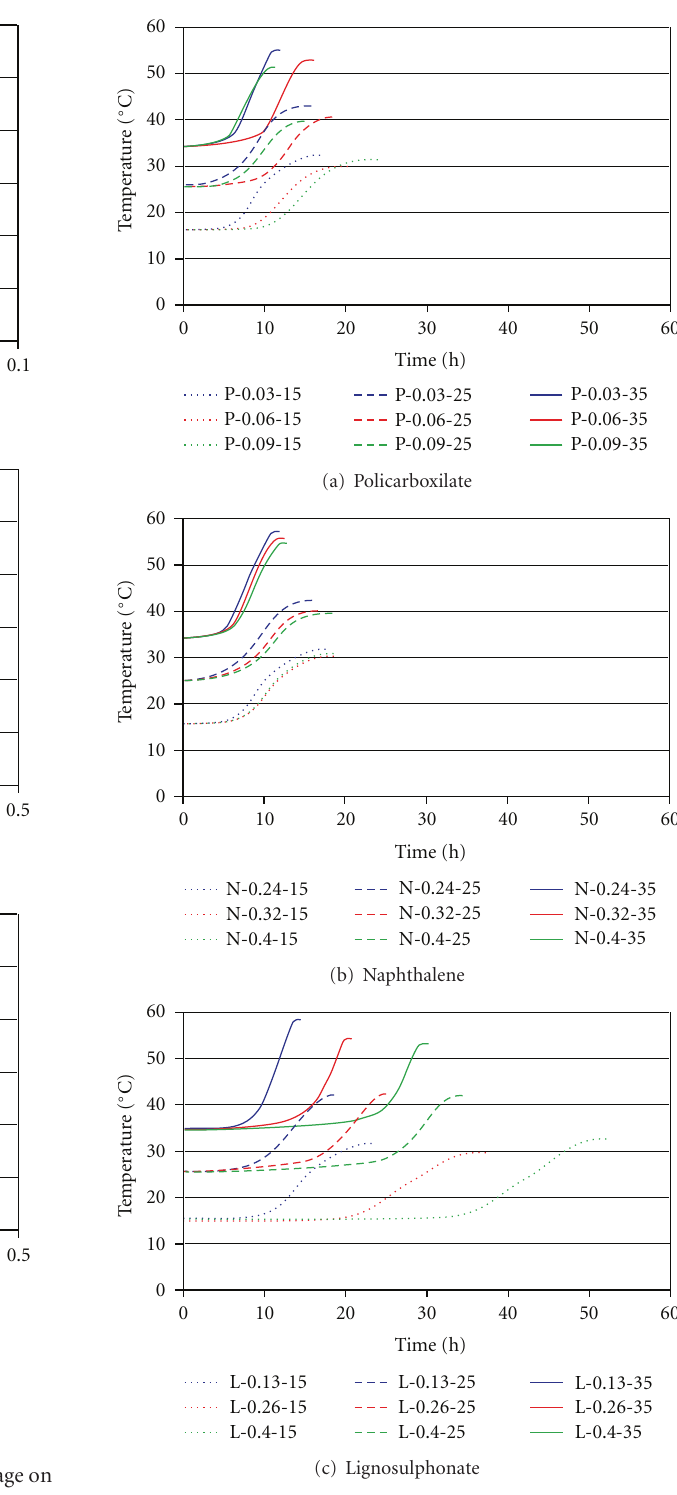
Figure 10: Time-temperature curves for the mortar mixtures produced with di ff erent